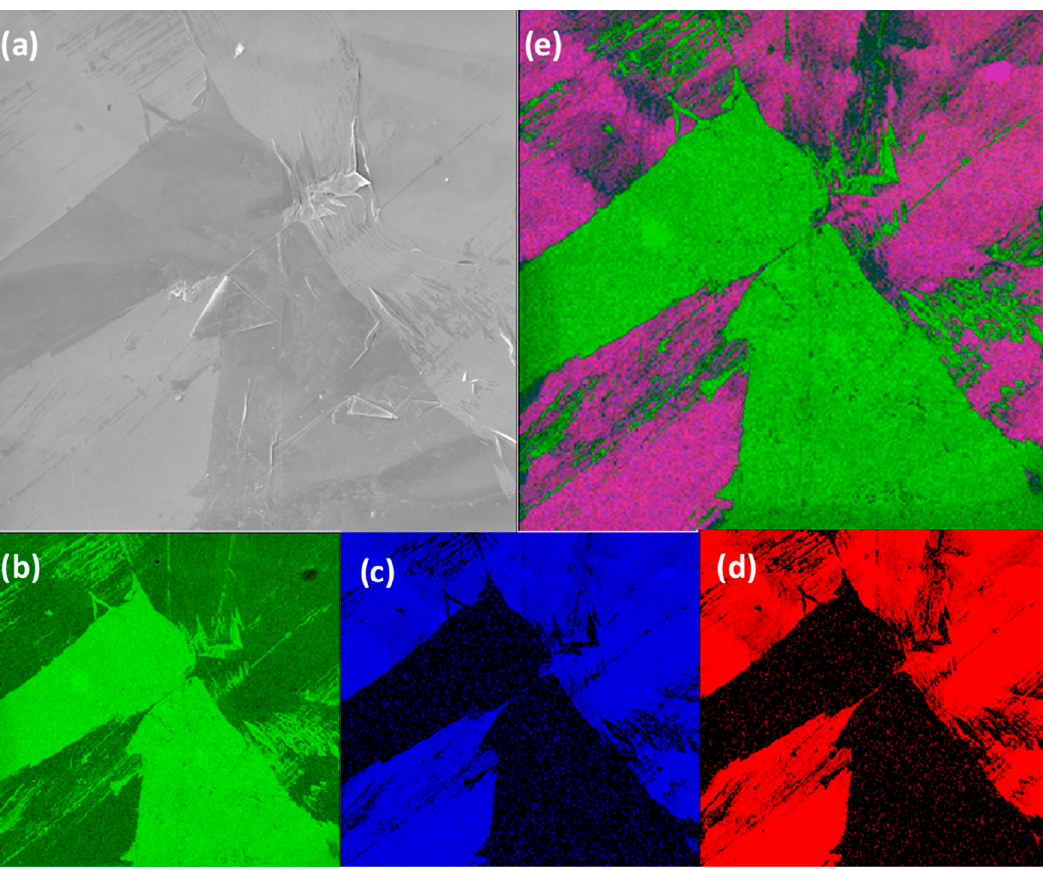
Figure 2. SEM image from propyltrimethoxysilane (PTMS) 3 ( a ), elemental maps of carbon ( b ), oxygen ( c ), and silicon ( d ), along with an RGB overlay of these three maps ( e ) (Field of view (FOV) 200 μ m).